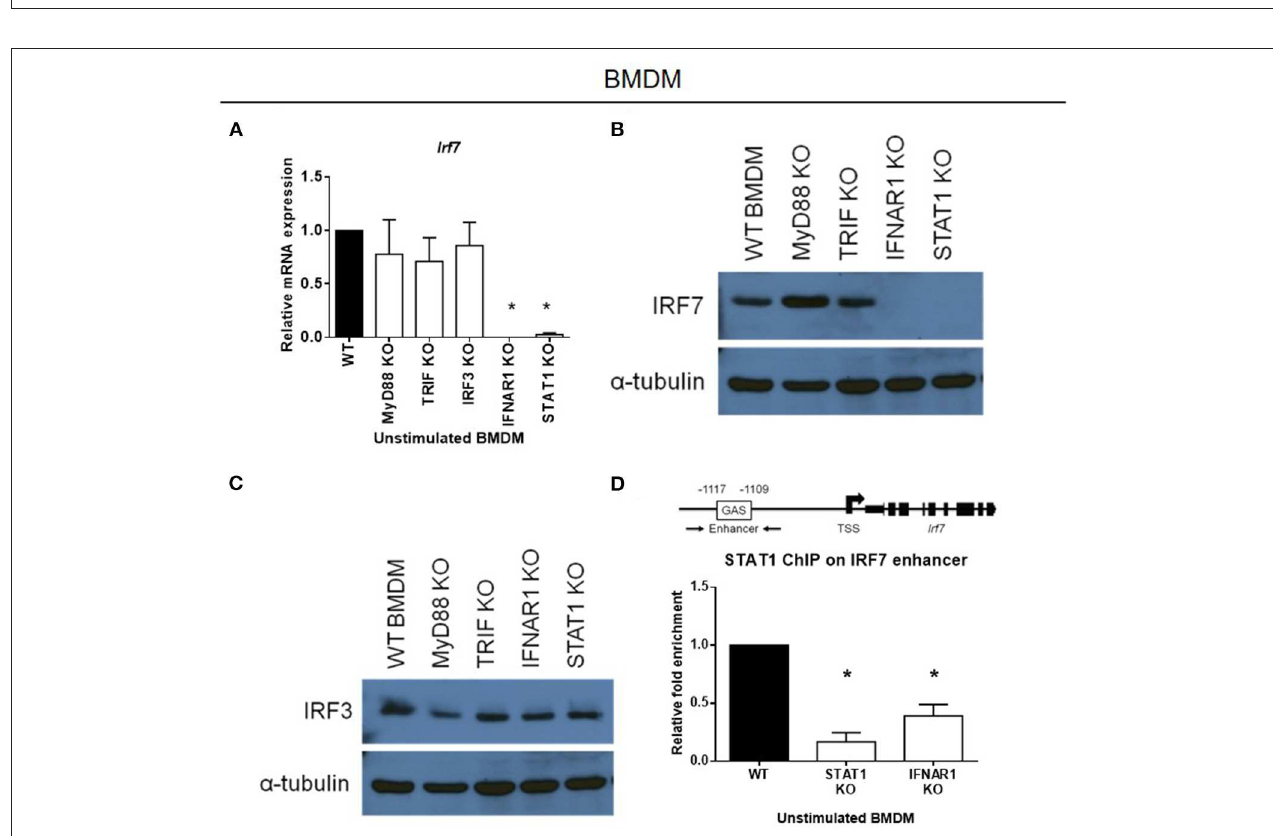
FIGURE 4 | Constitutive expression of IRF-7 in resting macrophages is sustained by constitutive IFNAR signaling and STAT1 binding to the Irf7 enhancer. (A) Real-time PCR analysis of Irf7 gene expression in resting BMDMs from MyD88, TRIF, IRF-3, IFNAR1, and STAT1 knockout mice, compared to wild-type control littermates. Irf7 expression was normalized to Gapdh , and expressed relative to the levels observed in un-stimulated wild-type control cells. Data are presented as mean ± SEM of at least three independent experiments. One-way ANOVA was used to calculate statistical differences (* p < 0.05). (B,C) Western immunoblot analysis of total IRF-7 (B) and total IRF-3 (C) protein expression in whole cell lysates of resting BMDMs from MyD88, TRIF, IFNAR1, and STAT1 knockout mice, compared to wild-type control littermates. Data are representative of at least two independent experiments. (D) ChIP analysis of STAT1 binding at the IRF-7 enhancer in resting BMDMs from STAT1 and IFNAR1 knockout mice compared to wild-type control littermates. ChIP-enriched DNA was normalized to input DNA and expressed relative to the levels observed in STAT1 ChIP in un-stimulated wild-type control cells. Data shown are presented as mean ± SEM of at least three independent experiments. One-way ANOVA was used to calculate statistical differences (* p <